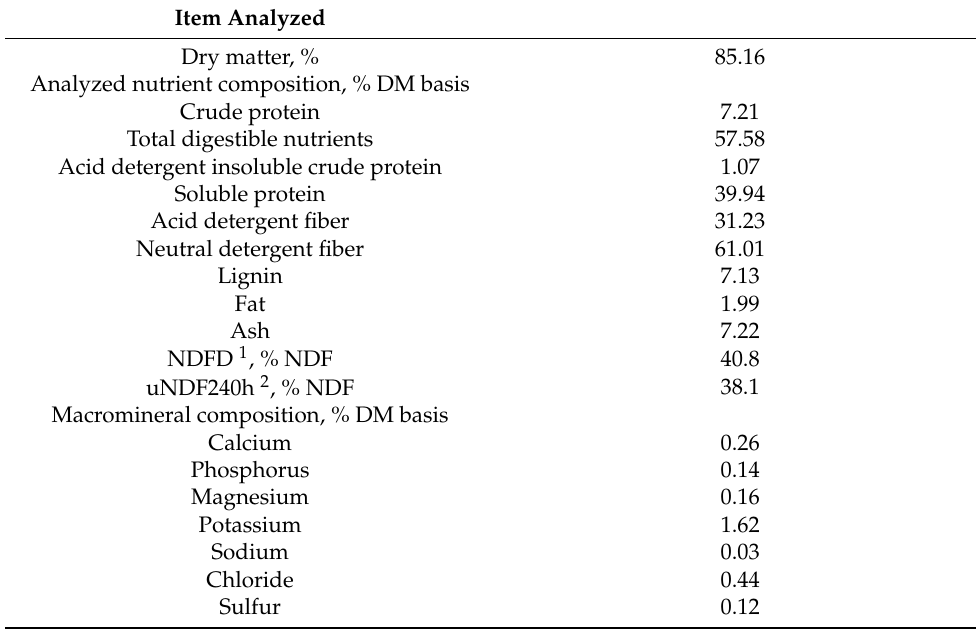
Table 2. Nutrient analysis of hay offered to fistulated 2- and 3-year-old beef cows. Item Analyzed Dry matter, % 85.16 Analyzed nutrient composition, % DM basis Crude protein 7.21 Total digestible